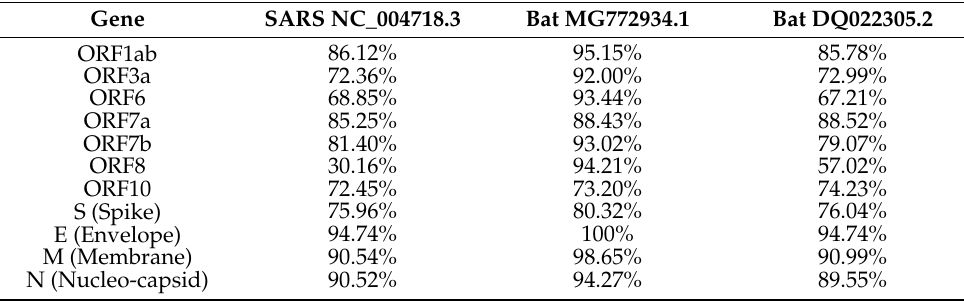
Table 2. Percentage identity between proteins of SARS-CoV-2 and the Coronaviridae family [31].